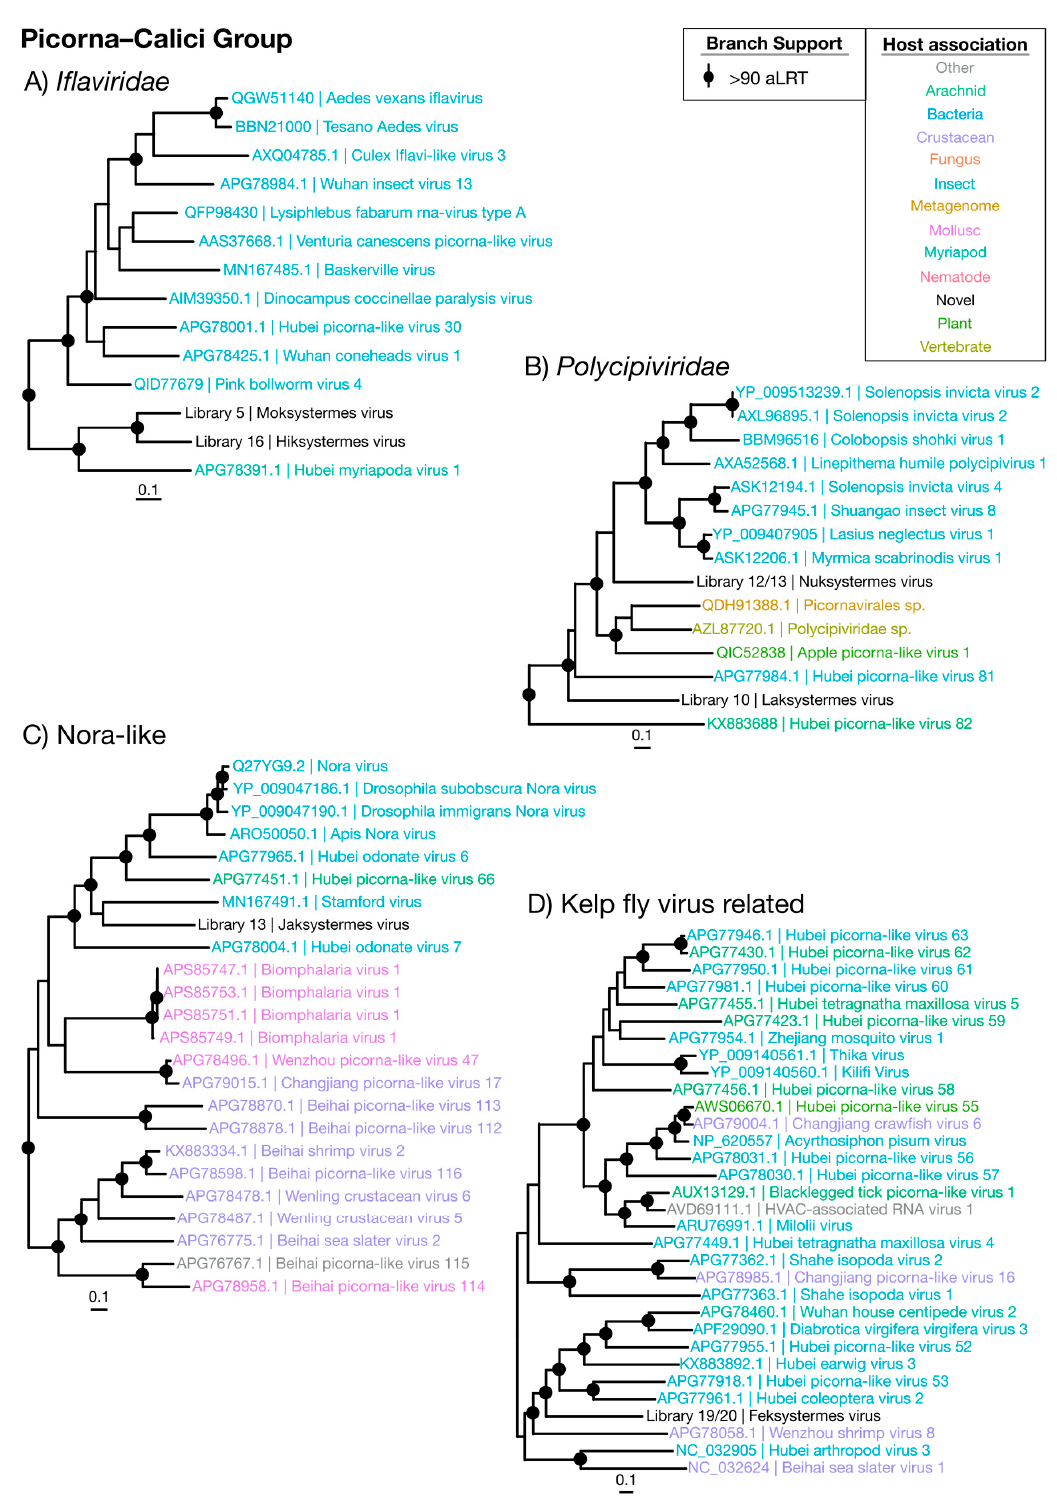
Figure 4. Phylogenetic trees of the viruses newly discovered here and their relatives in the Picorna–Calici group. Newly identified viruses are labeled with black text in the format “ < Library # | Virus name > ”, while related viruses are colored by their host association and are labeled in the format “ < Replicase protein accession >|< Virus name > ”. Black dots at tree nodes indicate high branch support (aLRT > 90).